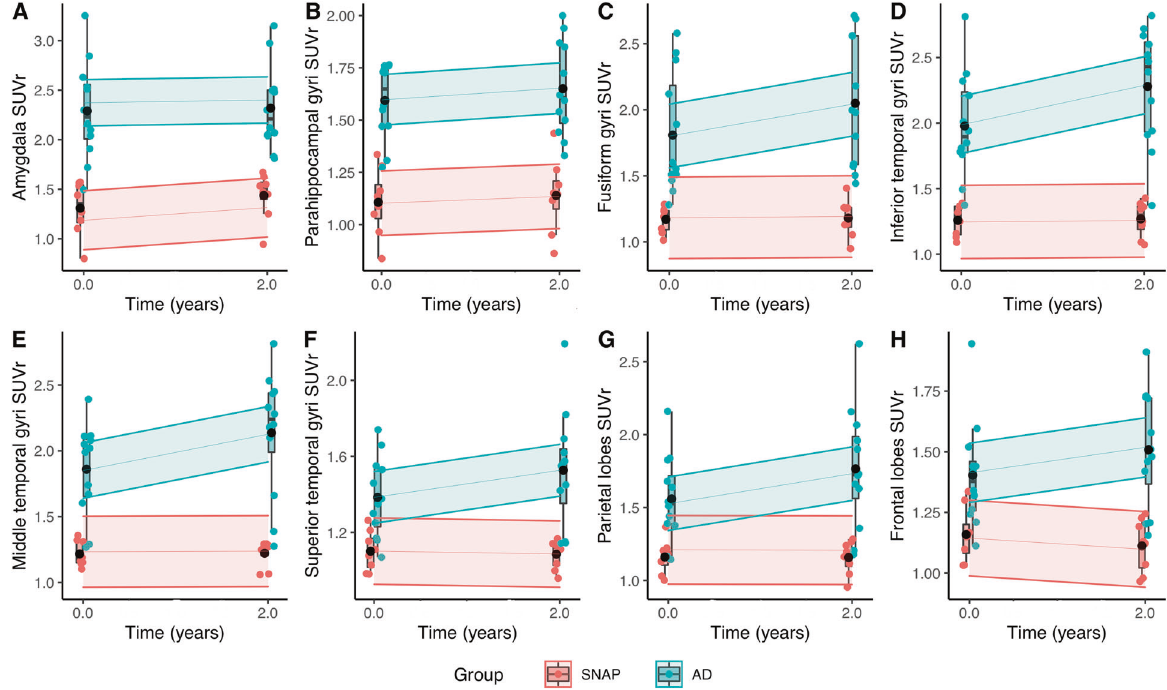
Fig. 5 Evolution of the tau tracer binding. Temporal diagrams representing the evolution of the tau PET SUVr in the amygdala ( A ), parahippocampal gyri ( B ), fusiform gyri ( C ), inferior temporal gyri ( D ), middle temporal gyri ( E ), superior temporal gyri ( F ), parietal lobes ( G ) and frontal lobes ( H ) at baseline and after 2 years of follow-up in the SNAP and AD groups. The ribbons represent the 95% con fi dence interval. Boxplots with individual points for each group are shown. The black point represents the mean value for each